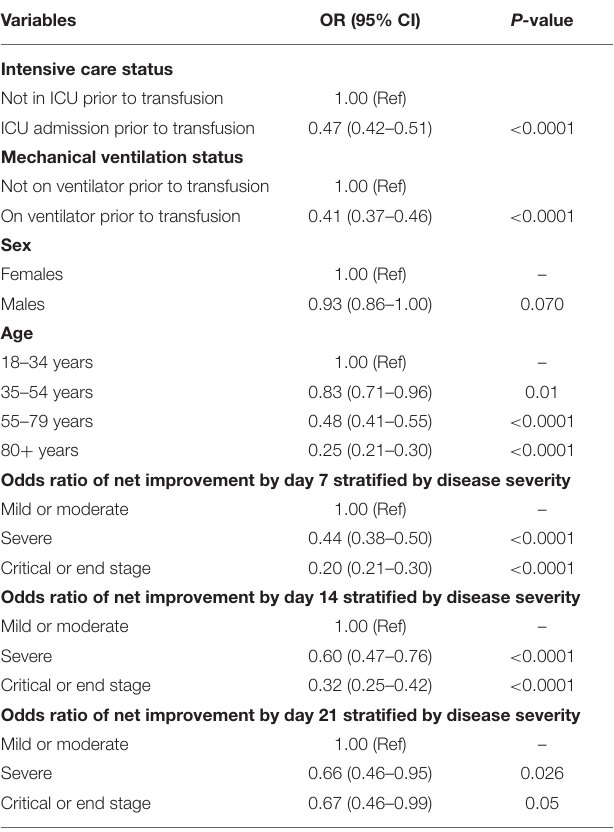
TABLE 3 | Multivariate analysis of improvement trajectory based on demographics and disease severity prior to treatment with COVID-19 convalescent